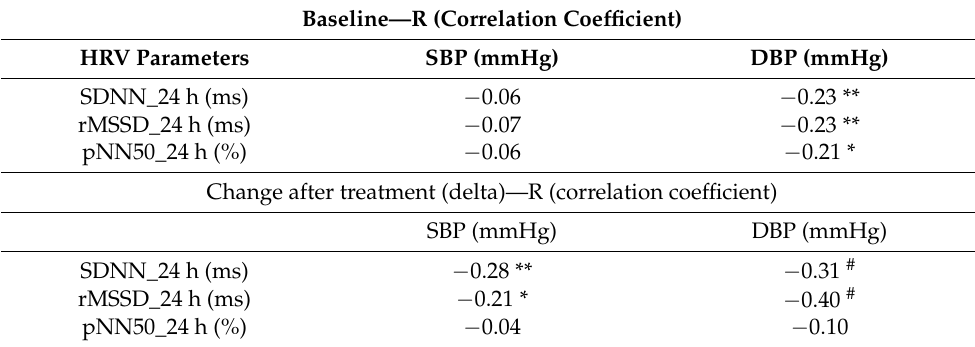
Table 2. Correlations of heart rate variability parameters with systolic and diastolic blood pressure for baseline absolute values and changes (delta) after 12-month treatment.